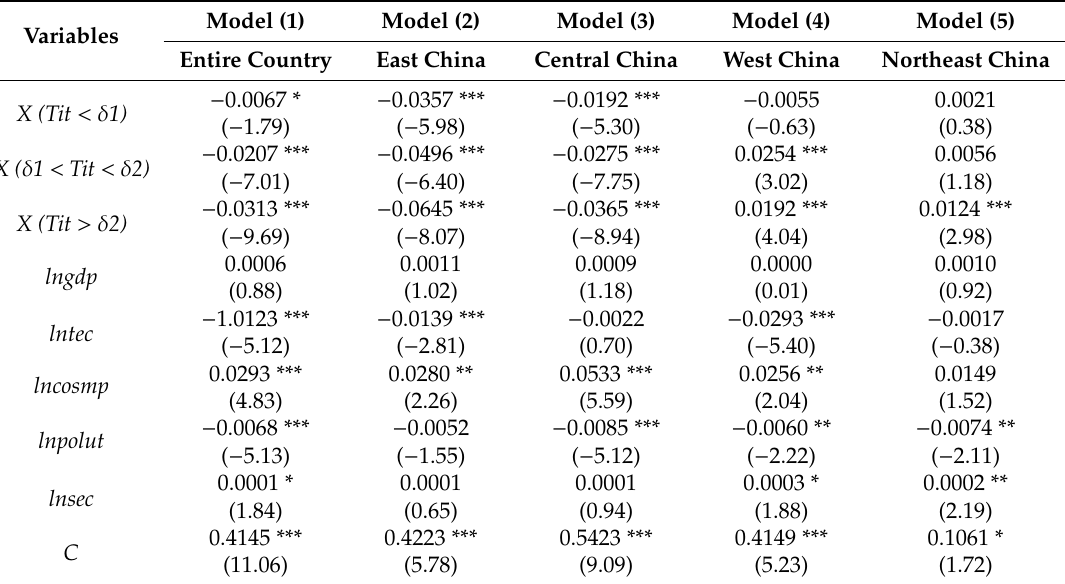
Table 7. Model parameter estimation